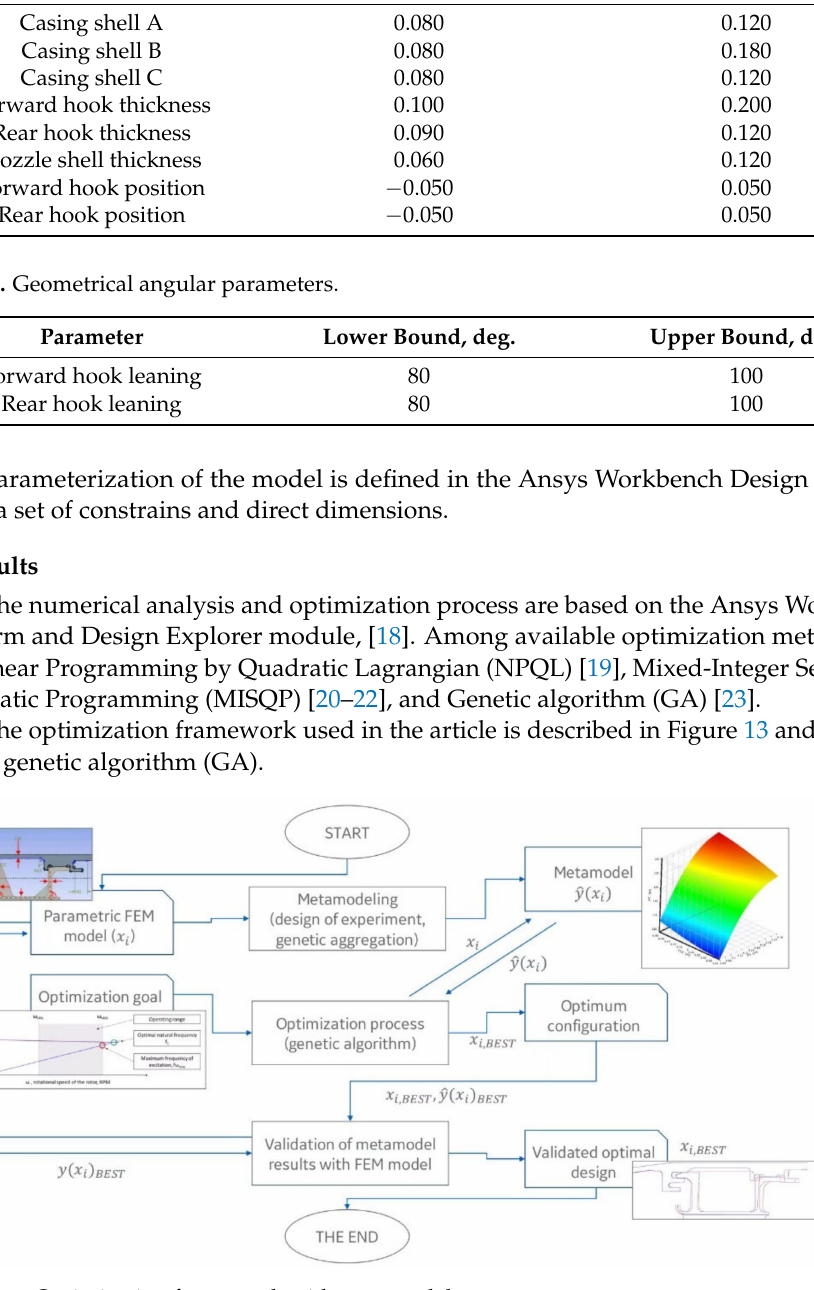
Figure 13. Optimization framework with